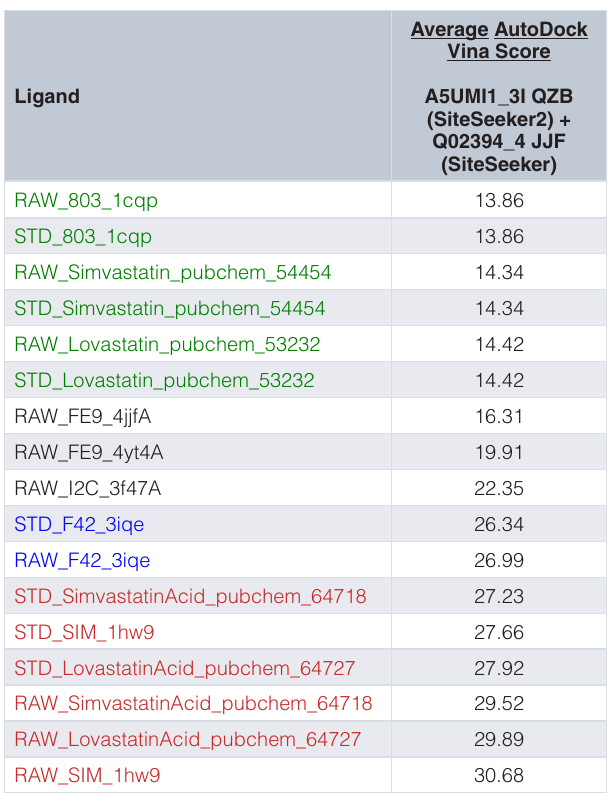
Table 3. Average AutoDock Vina scores over the top-two sites (see Table 2). Statin ligands highlighted in green are lactone form, or red if hydroxyacid form. F420 ligands are in blue. Tautomeric representations are included in each average. Standardized ligands are prefixed with “STD_,” those without standardization are prefixed with “RAW_” (see text). Ligand names have suffixes containing either the PDB entry they were originally extracted from, or their respective PubChem 29 CIDs.